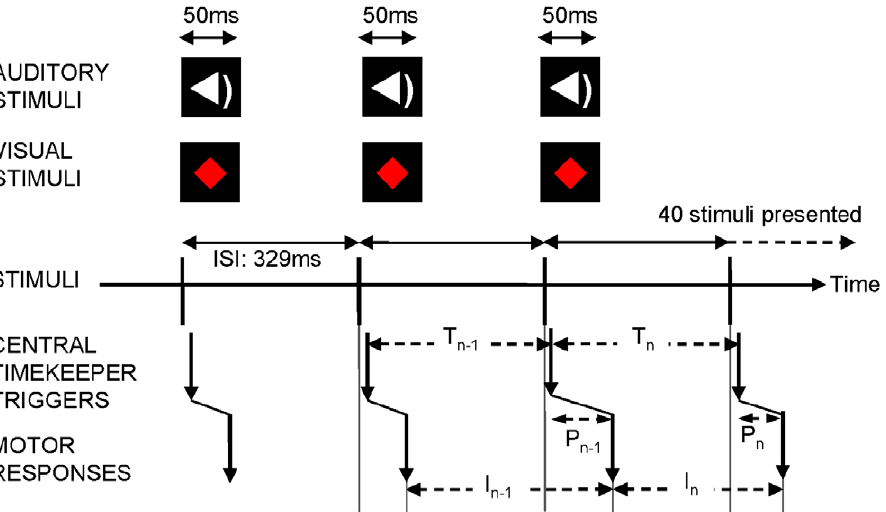
Figure 1. Representation of finger tapping stimuli, response synchrony and variance components. Stimulus intervals of 329 ms are represented by the lines with bidirectional arrows. A central timekeeping mechanism generates response triggers with intervals T n which are subject to peripheral implementation delays (P n ) and result in the recorded inter-response intervals of motor responses (I n ). The mean difference from the absolute interval is calculated as inter-stimulus interval (ISI) minus I n